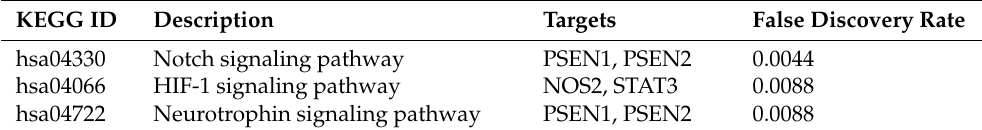
Table 3. Targets in three signaling pathways’ enrichment related to AMPs—AFPs’ axis.